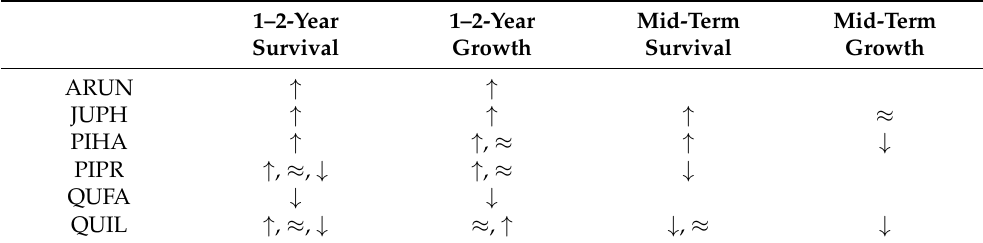
Table 4. General assessment of field performance in survival and growth in both the early (first two years) and the mid-term (10 years) for the six species assayed in this work within the framework of previously published works (see text for references). ↑ and ↓ arrows stand for higher or lower performance in this work, whilst ≈ stands for similar performance. Mid-term studies were not found for some